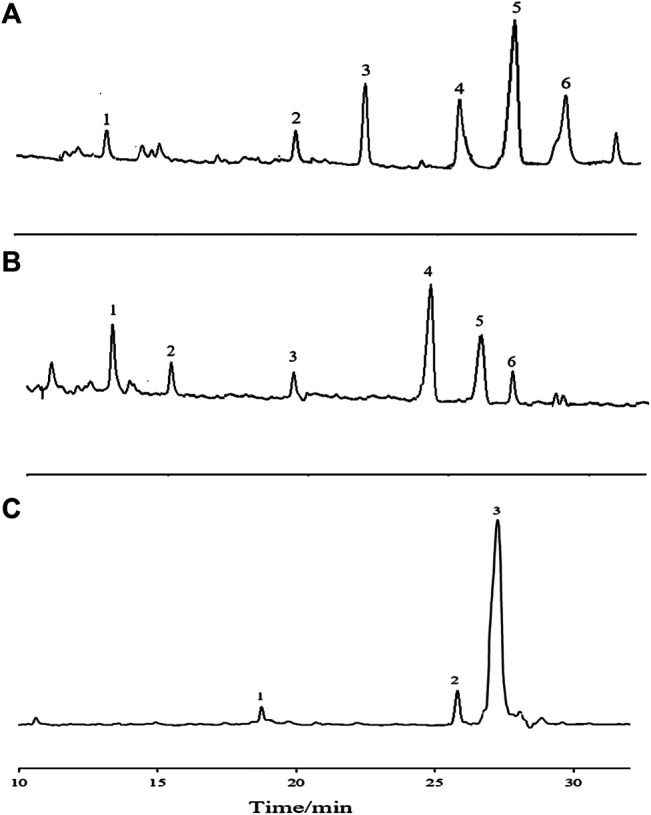
The GC-MS total-ion chromatogram of methylation analysis of APS-Ⅰ (A), APS-Ⅱ (B) and APS-Ⅲ (C).